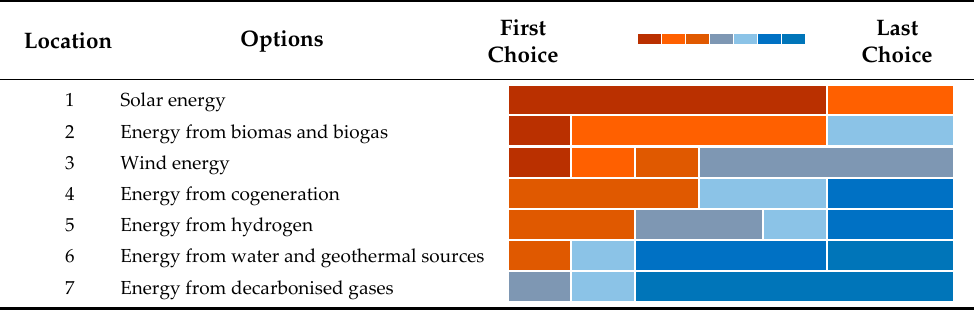
Table 4. Development of energy sources in Eastern Poland resulting from potential growth determi- nants of the macroregion.